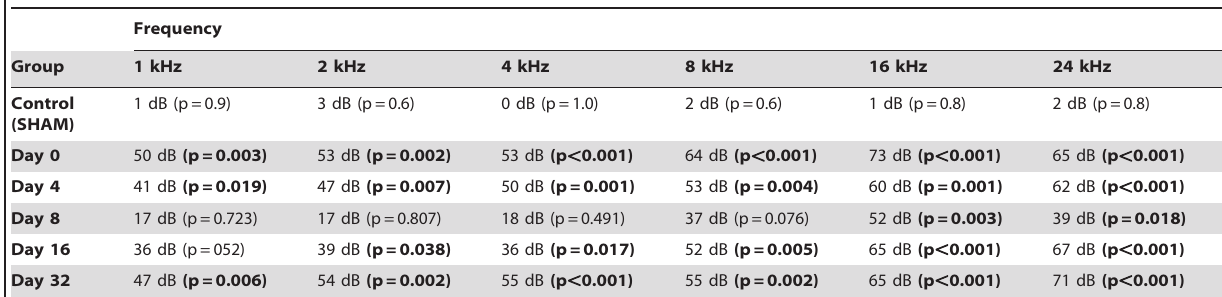
Table 1. Post Acoustic Trauma Threshold shifts in all exposure groups (Ipsilateral